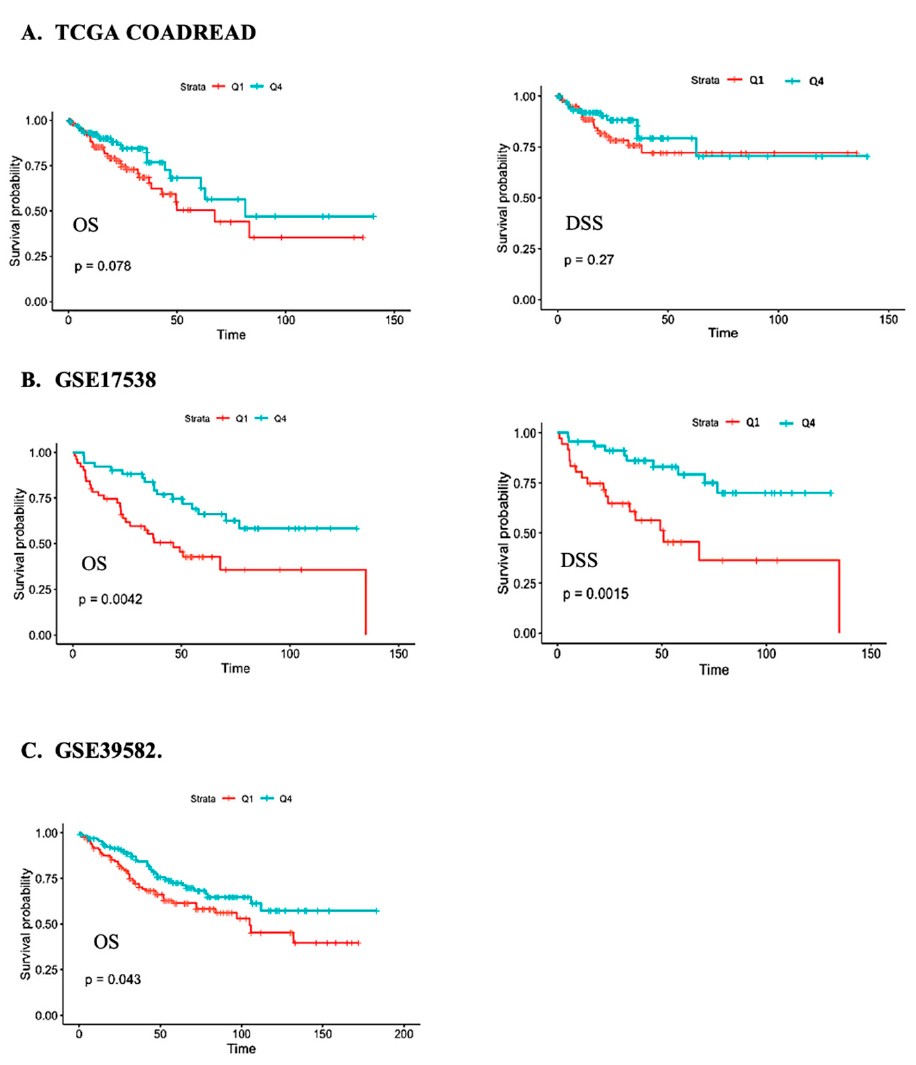
Figure 1. Kaplan-Meier survival analysis of the overall survival (OS) and disease-specific survival (DSS) of individuals with CRC in the ( A ) TCGA COADREAD, ( B ) GSE17538, and ( C ) GSE39582 studies in relation to CFTR expression for the fourth (green) versus first (red) quartile.